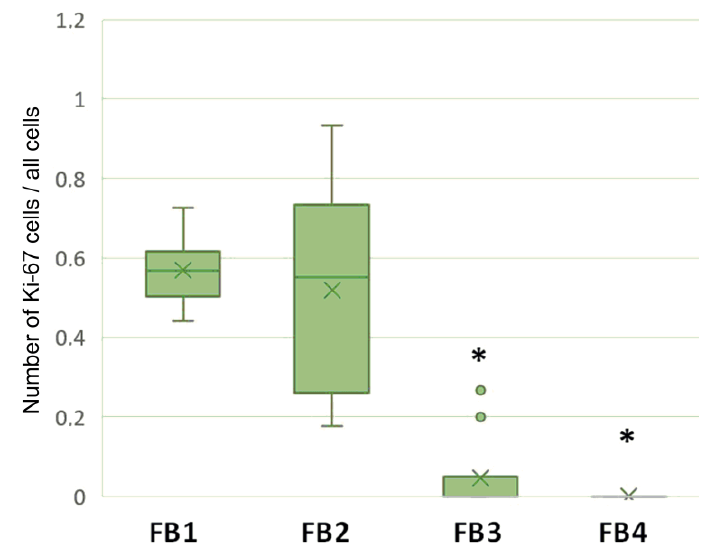
Figure 9. Evaluation of the proliferative properties of UC MSCs by the rate of Ki-67 + cells. * p < 0.05 in comparison with FB-1 .